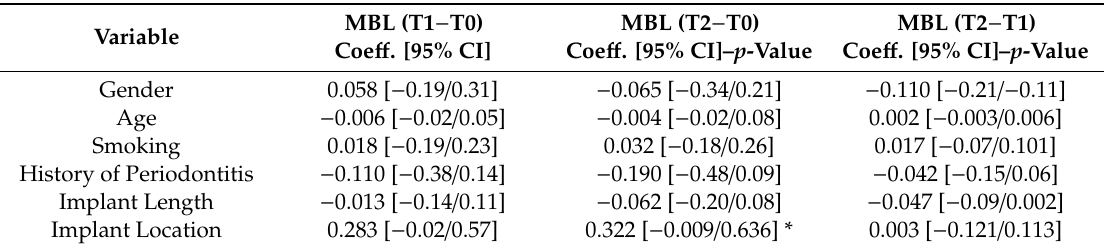
Table 4. Univariate analysis of baseline factors potentially influencing marginal bone loss (MBL).